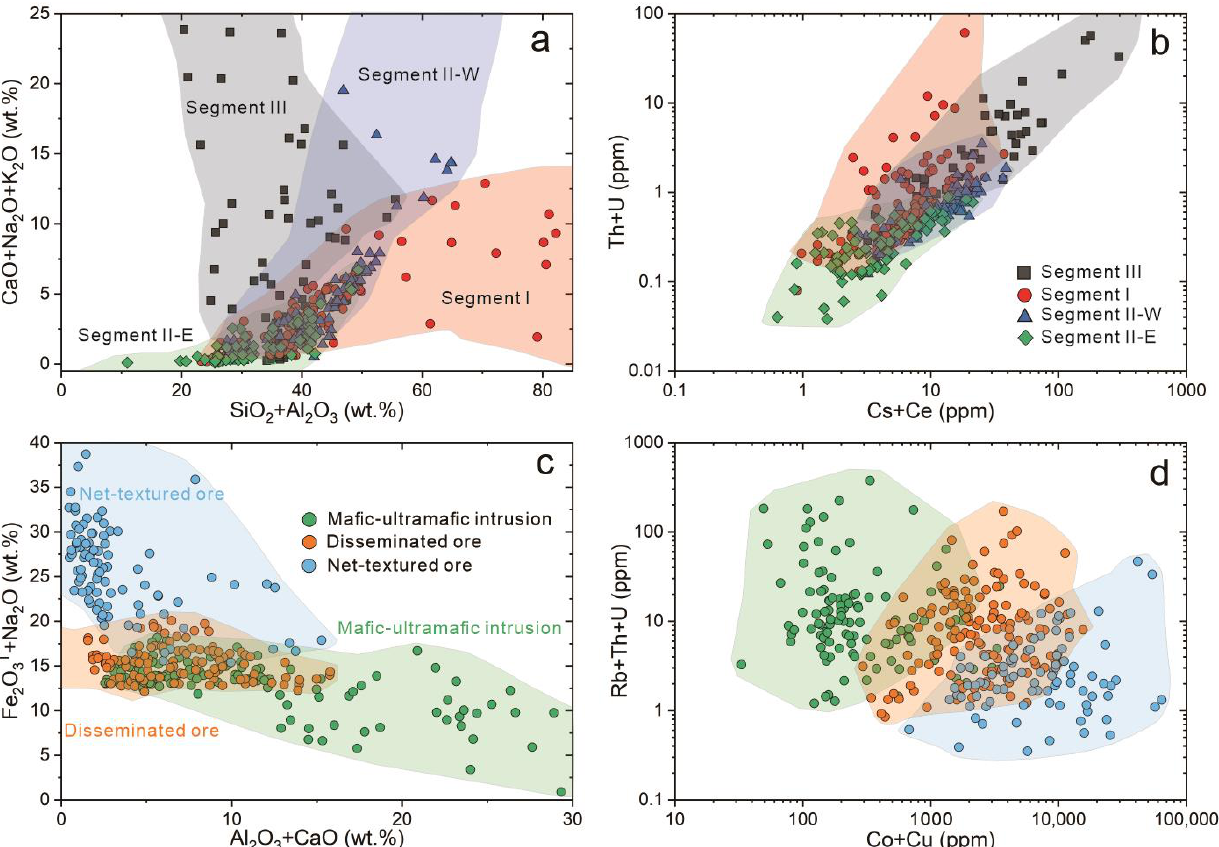
Figure 12. New discriminant binary diagrams, based on the PLS-DA results from this study, that could be used as complementary tools in prediction tasks in addition to PLS-DA models. Plot of the ( a ) SiO 2 + Al 2 O 3 vs. CaO + Na 2 O + K 2 O and ( b ) Cs + Ce vs. Th + U to discriminate the different segment of Jinchuan deposit. Plot of the ( c ) Al 2 O 3 + CaO vs. Fe 2 O 3T + Na 2 O and ( d ) Co + Cu vs. Rb + Th + U to discriminate the different ore types of Jinchuan deposit. Data sources as in Figure 6.